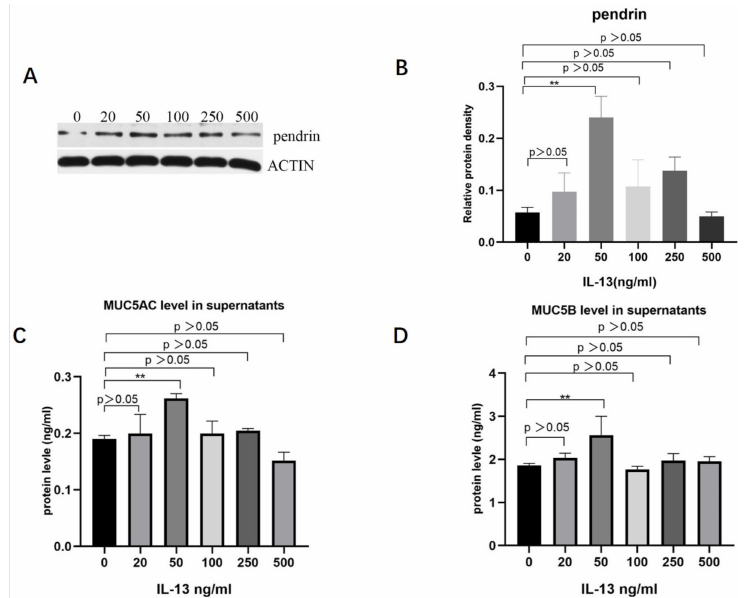
Figure 3. With stimulation by IL-13 (0, 20, 50, 100, 250, and 500 ng/mL), MUC5AC, MUC5B, and pendrin expression are upregulated in primary HNECs. ( A , B ) Show pendrin revealed by WB. ( C , D ) Enzyme-linked immunosorbent assay (ELISA) results showing IL-13-induced MUC5AC and MUC5B expression. ** represents p < 0.01.